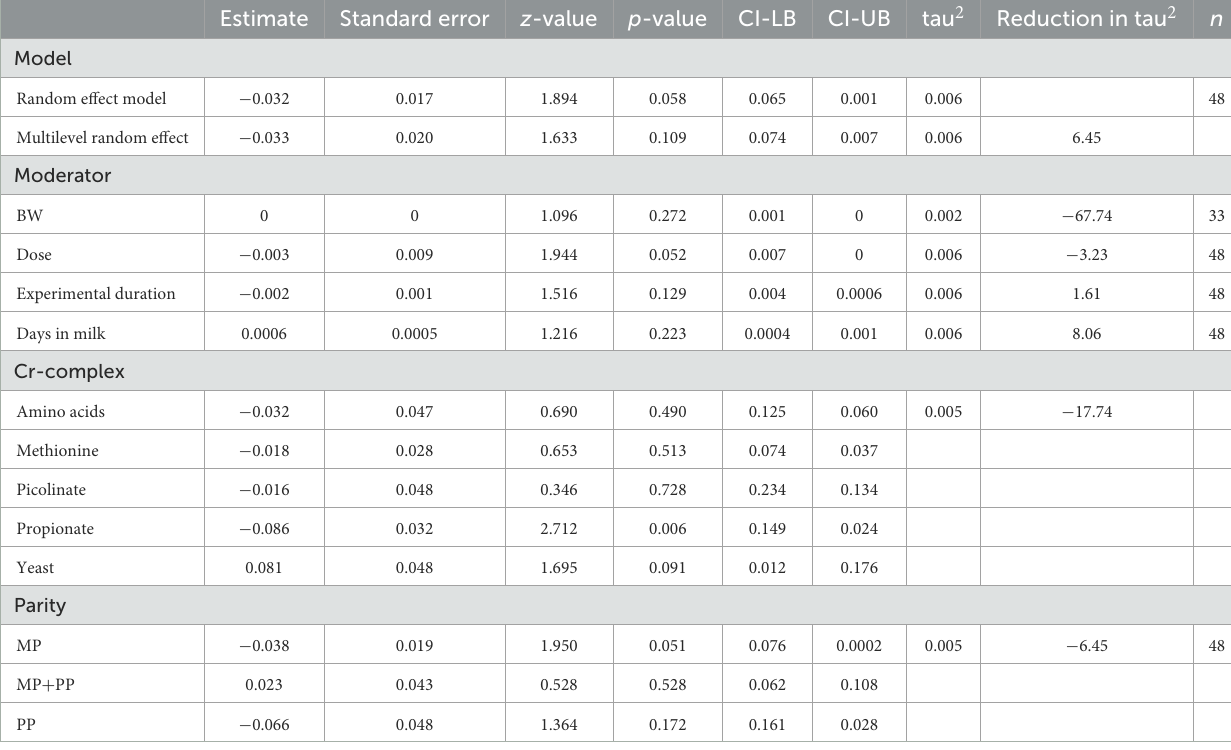
TABLE 3 A summary of statistical models and moderators for the milk protein meta-analysis. Estimate